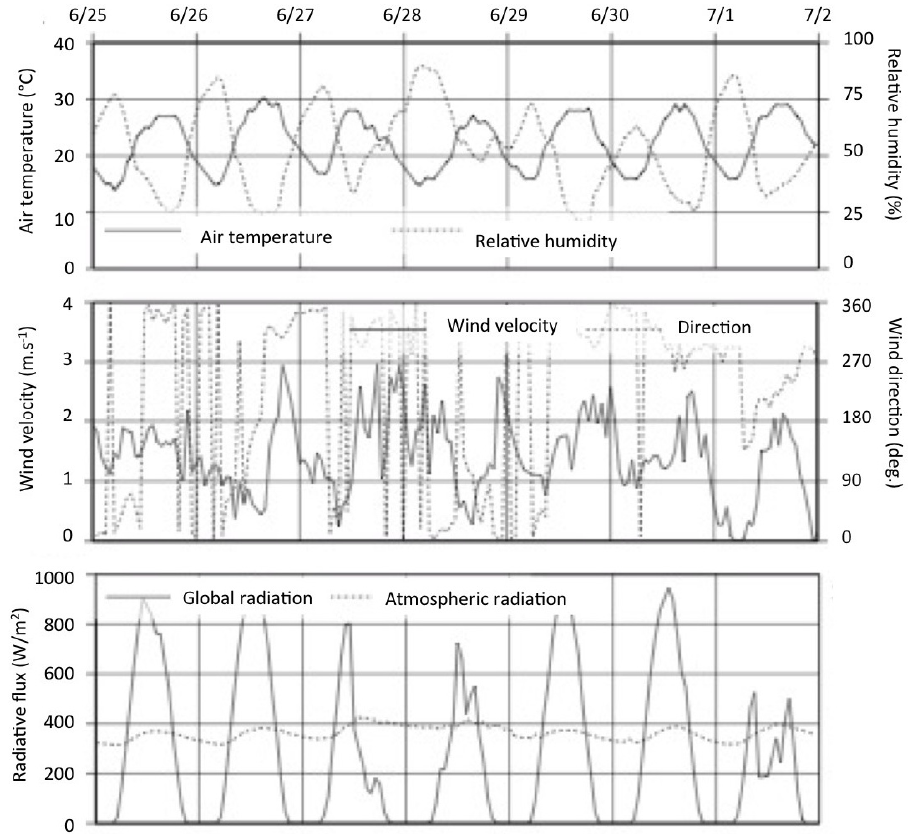
Figure 4. Weather conditions measured on the Dunant roof from 25 June to 2 July 2010.